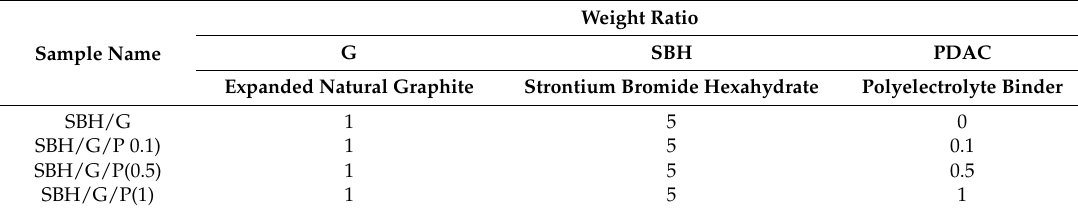
Table 1. Summary of the prepared samples.